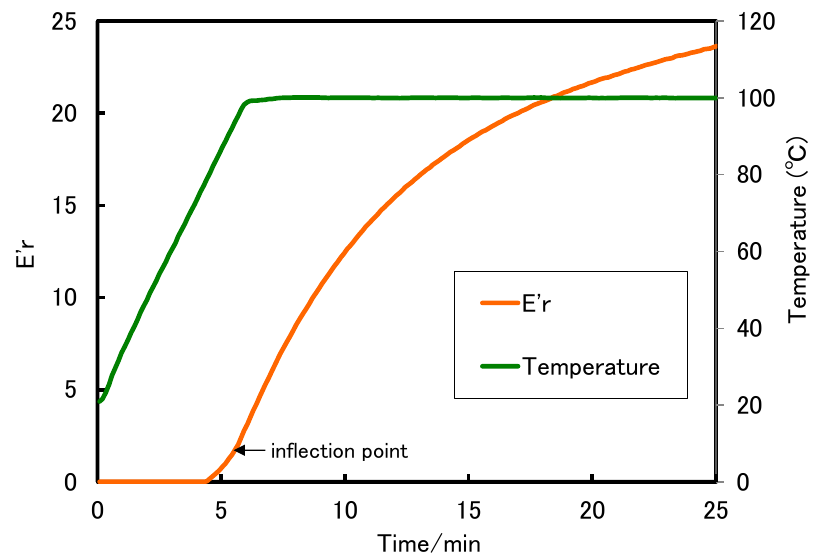
Plotting the measured relative storage modulus (E’r) against time, we can see that the curve changes from a downward convex curve to an upward convex curve according to the progress of time (hereafter, this point of change is called the “inflection point”) (Figure 2).